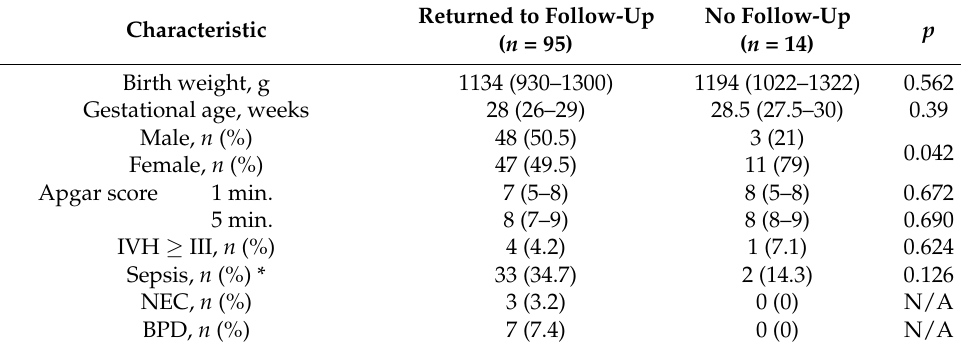
Table 1. Main demographic characteristics of the follow-up infants